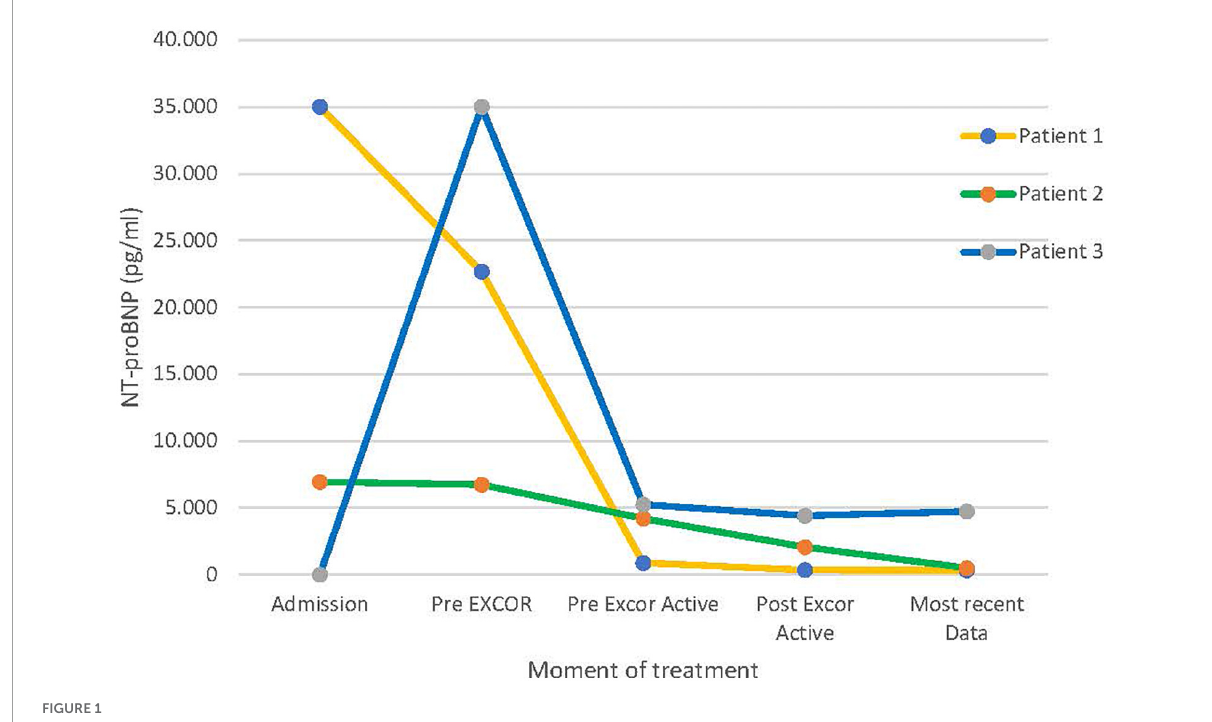
FIGURE1 Levels of NT-proBNP over the course of the treatment.